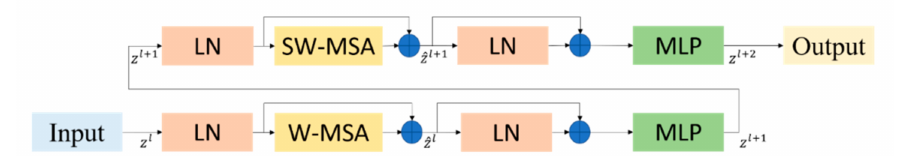
Figure 3. The architecture of Swin Transformer.